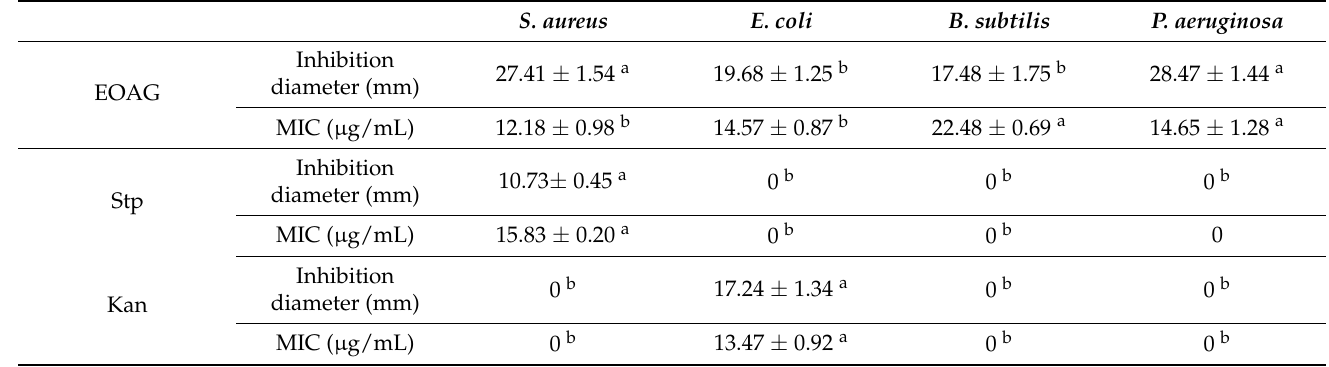
Table 2. Antibacterial power of EOAG as assessed by use of inhibition zone diameters and MIC assays. S.